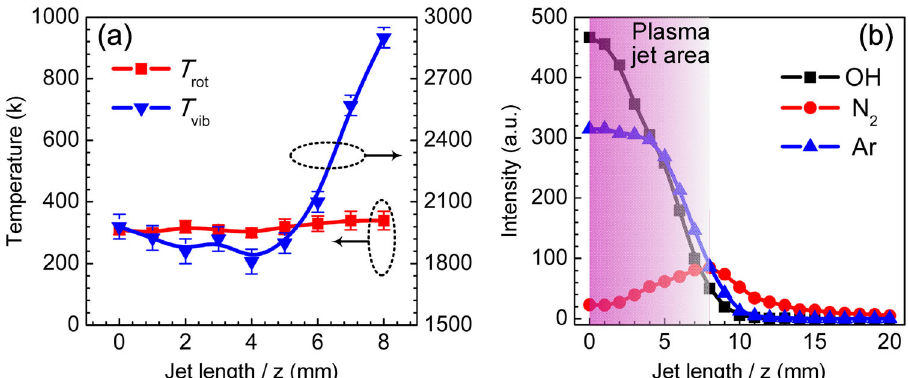
Fig. 6 Plasma nonequilibrium and chemical activity. a The distributions of the rotational temperature ( T rot ) and vibrational temperature ( T vib ) along the plasma jet ( z -axis). The red solid square shows the case of rotational temperature, while the blue solid inverted triangle indicates the case of vibrational temperature. The plots show an average of fi ve experimental measurements, and the measurement uncertainty (one standard deviation) is indicated by the error bars and is estimated to be 5 – 9% for the rotational temperature and 2 – 4% for the vibrational temperature. b The distributions of the OES of active species along the plasma jet (or z -axis). The black solid square shows the case of excited hydroxyl radical (OH), the red solid circle indicates the case of excited nitrogen molecule (N 2 ), and the blue solid triangle represents the case of excited argon atom (Ar). The plots show an average of fi ve experimental measurements and the measurement uncertainty (one standard deviation) is estimated to be 7 – 9%. Since the error bars are too small to be shown distinctly, especially in the range of larger plasma jet length, they are not displayed. The shaded region is introduced in order to focus the attention on the plasma jet area at the gas fl owrate of 2.2 l min − 1